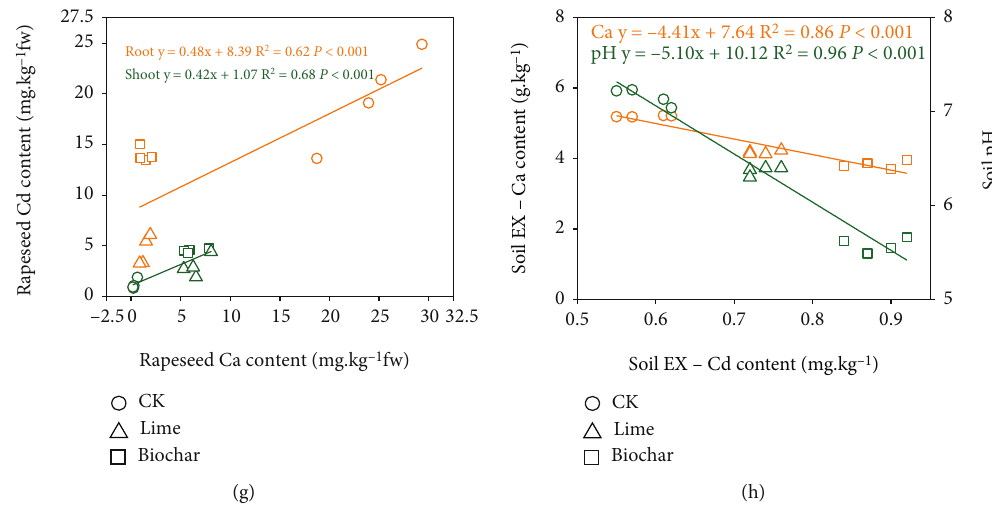
Figure 1: Cd accumulations and related factors in soil- B. napus system under three treatments. B. napus : Brassica napus L. ; EX-Cd: exchangeable cadmium; EX-Ca: exchangeable calcium; TF: translocation factor; and BCF: bioconcentration factor. Means ± SD ( n = 4 ). Di ff erent lowercase letters indicate signi fi cant di ff erences ( P < 0 : 05 ) between the three